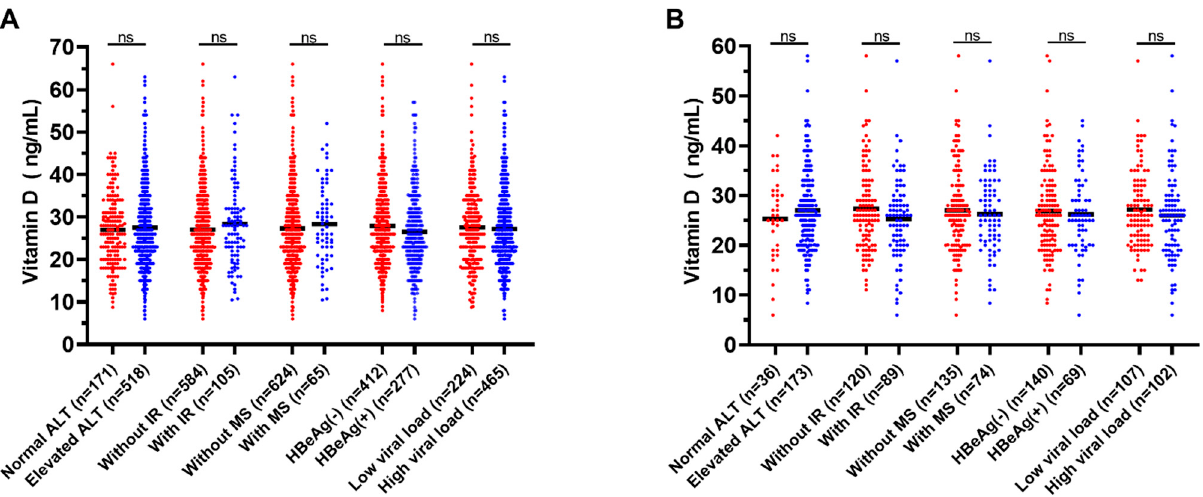
Figure 3. Serum VitD levels in CHB patients with different conditions without ( A ) or with ( B ) MAFLD. CHB, chronic hepatitis B; MAFLD, metabolic-associated fatty liver disease; VitD, vitamin D; ALT, alanine aminotransferase; IR, insulin resistance; MS, metabolic syndrome; HBeAg, hepatitis B en- velope antigen. Elevated ALT is defined for males and females as >30 and 19 U/L, respectively. Insulin resistance is defined as homeostasis model assessment of insulin resistance >2.5. Metabolic syndrome is defined as meeting at least three of the following criteria: (a) waist circumference ≥ 90 cm (males) and ≥ 80 cm (females); (b) blood pressure ≥ 130/85 mmHg or use of hypertensive medication; (c) reduced high-density lipoprotein cholesterol level (<1.03 mmol/L for males, <1.3 mmol/L for females); (d) elevated triglyceride level ( ≥ 1.7 mmol/L); and (e) elevated fasting plasma glucose ( ≥ 5.6 mmol/L) or drug treatment for hyperglycemia. High viral load is defined as HBV DNA level ≥ 2000